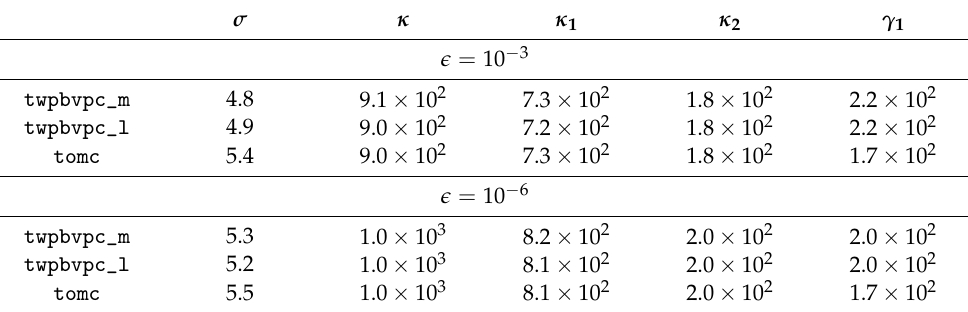
Table 20. Goddard Rocket problem: conditioning parameters computed using tol = 10 − 6